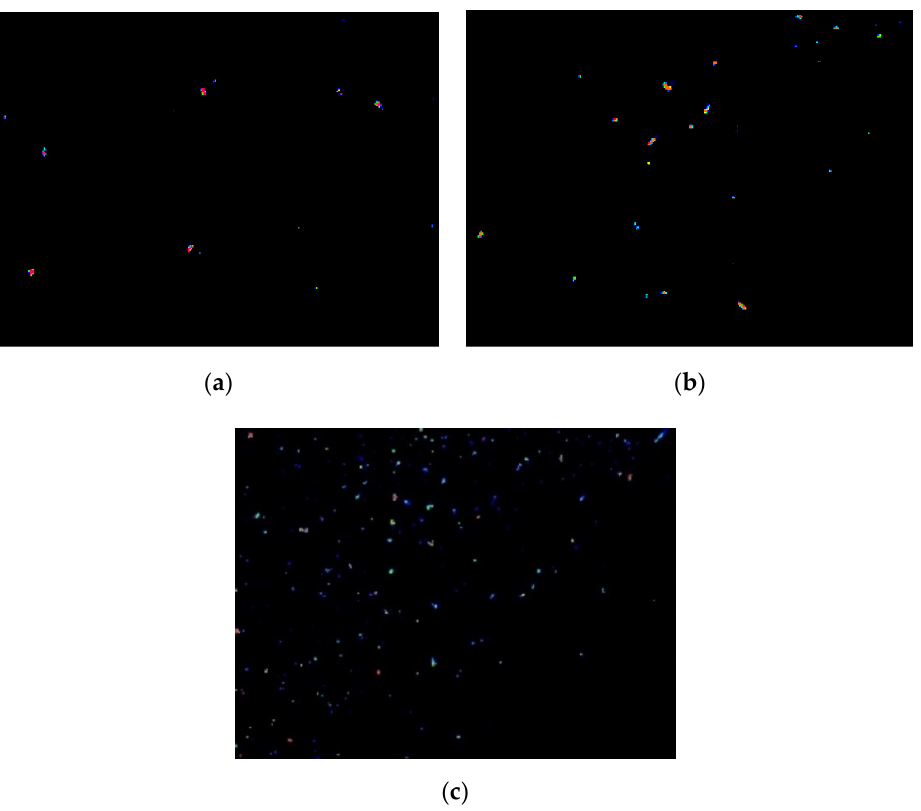
Figure 6. Example of selected thermograms / frames: ( a – c ) are the small, medium, and large number of firebrands (pellets),